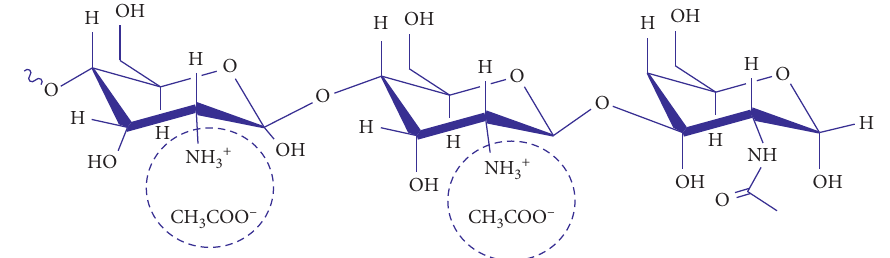
Figure 5: Structure of lyophilized chitosan salt.